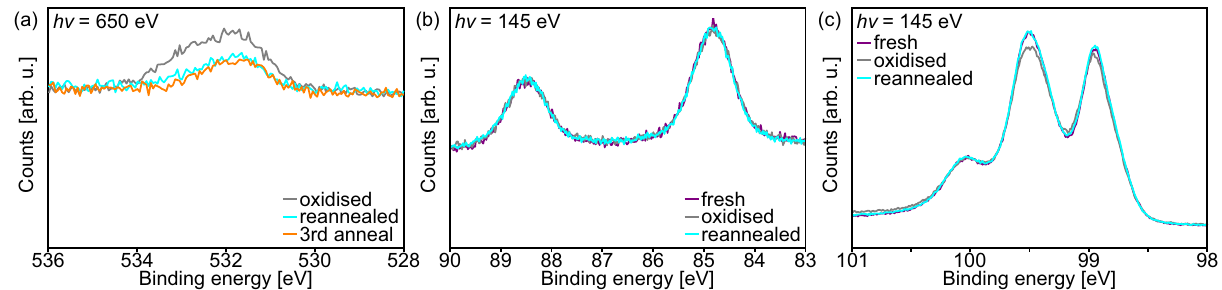
Figure 7. ( a ) O 1s spectra of a more than 17 h old Au silicide nanowires sample before and after reannealing. ( b ) Au 4f and ( c ) Si 2p spectra of a freshly prepared Au silicide nanowires sample, a slightly oxidised one, and a reannealed one. All spectra were obtained in NE and the spectra of a diagram were normalized to show the same intensity at low binding energies.